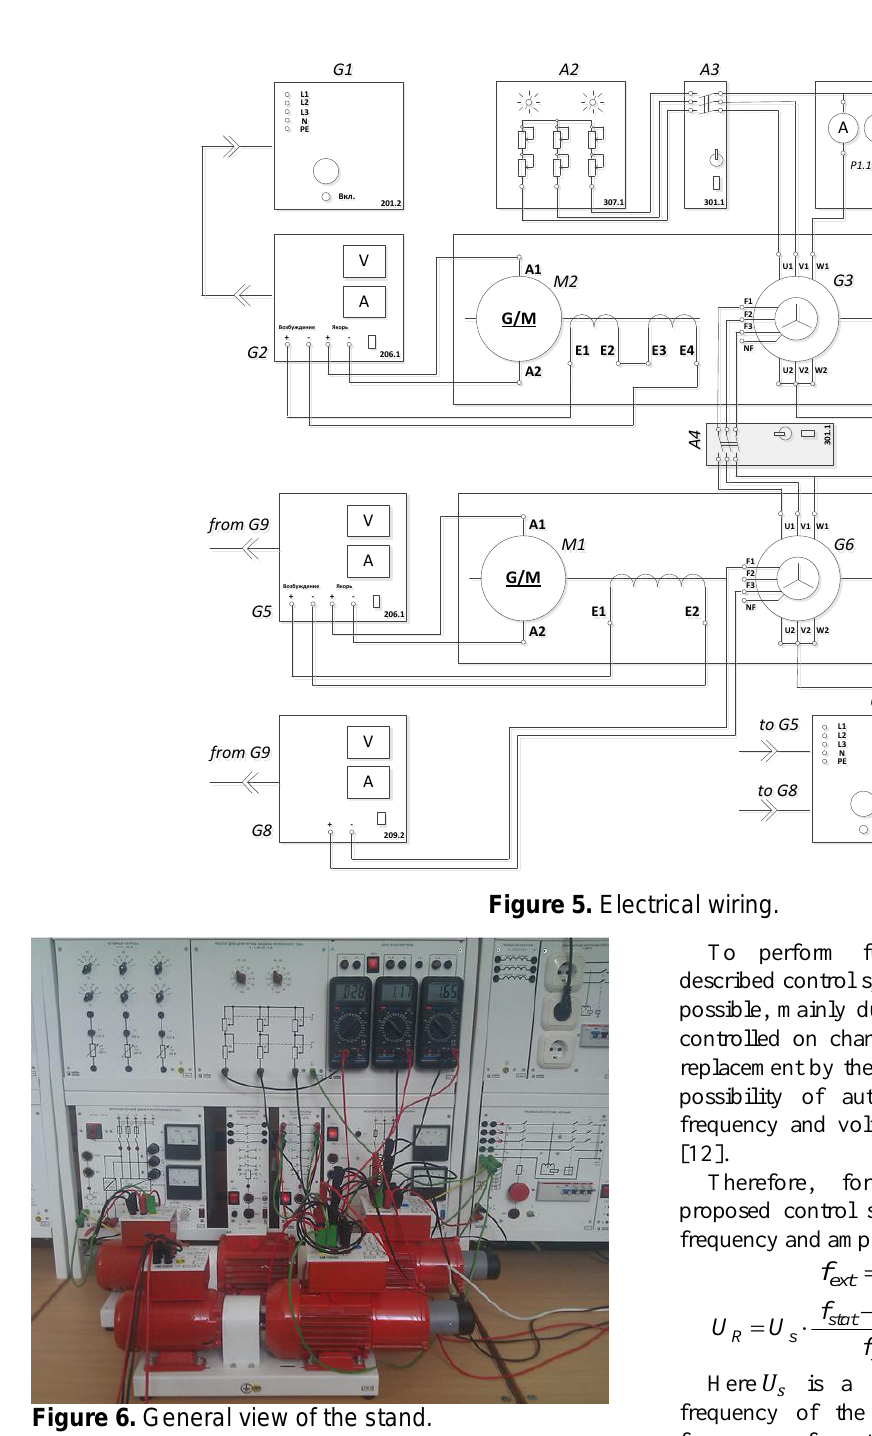
Figure 6. General view of the